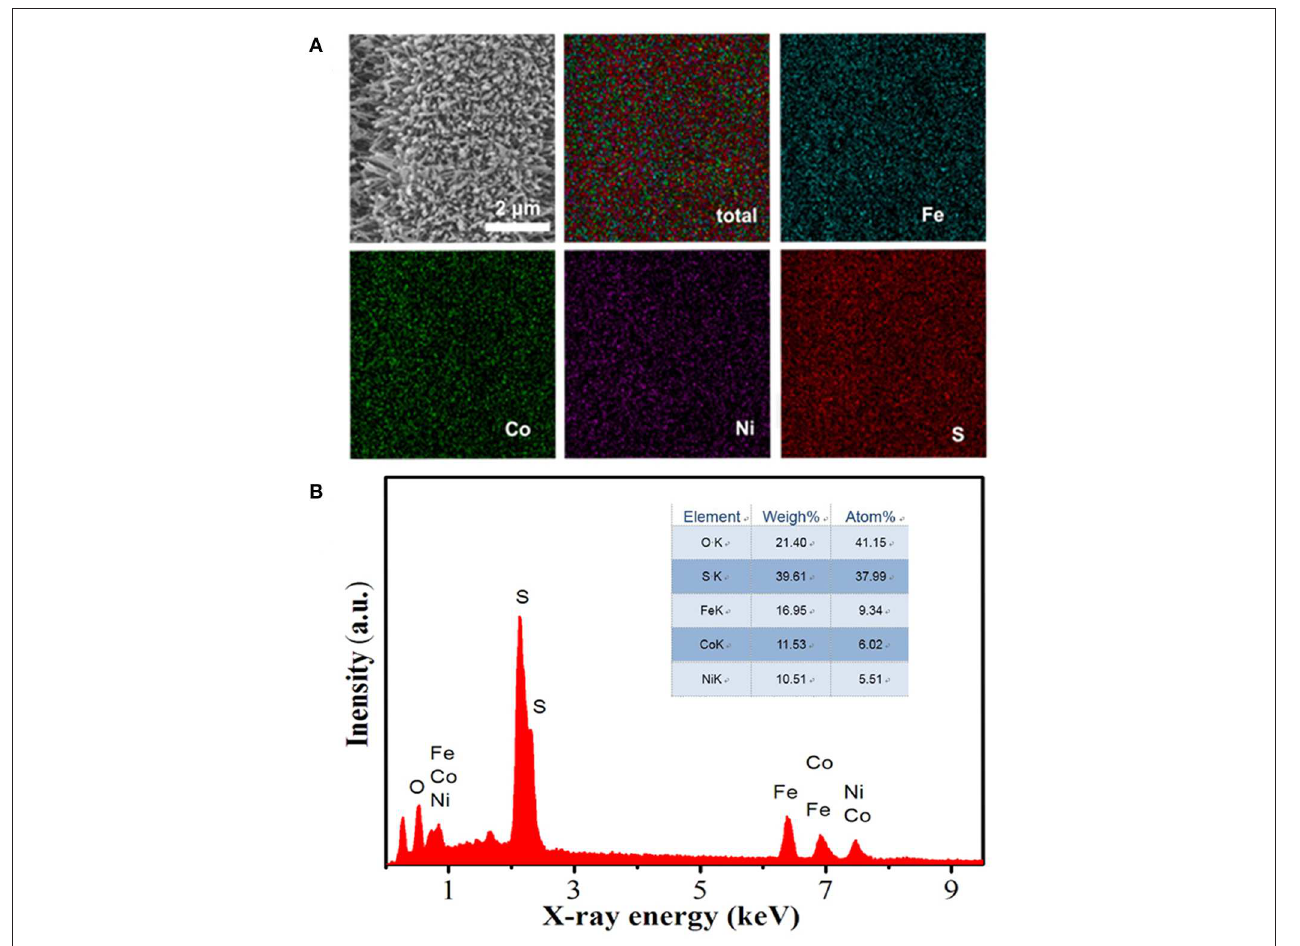
FIGURE 3 | (A) Energy-dispersive X-ray (EDX) mapping images of FeCoNiS-FeOx. (B) EDX element distribution pattern.